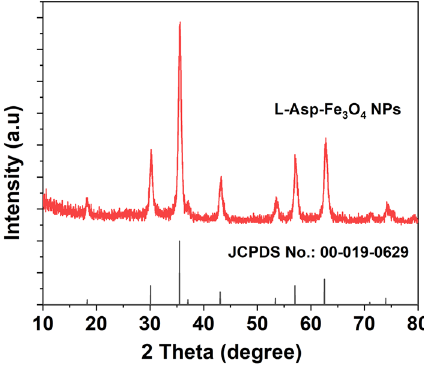
Fig. 2 The powder X-ray diffraction pattern of L-Asp capped Fe NPs